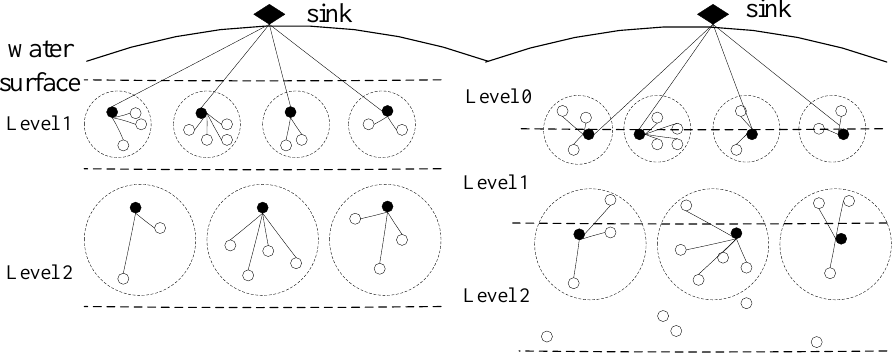
Figure 1. Sketch map of node dynamic hierarchical and non-uniform node clustering.